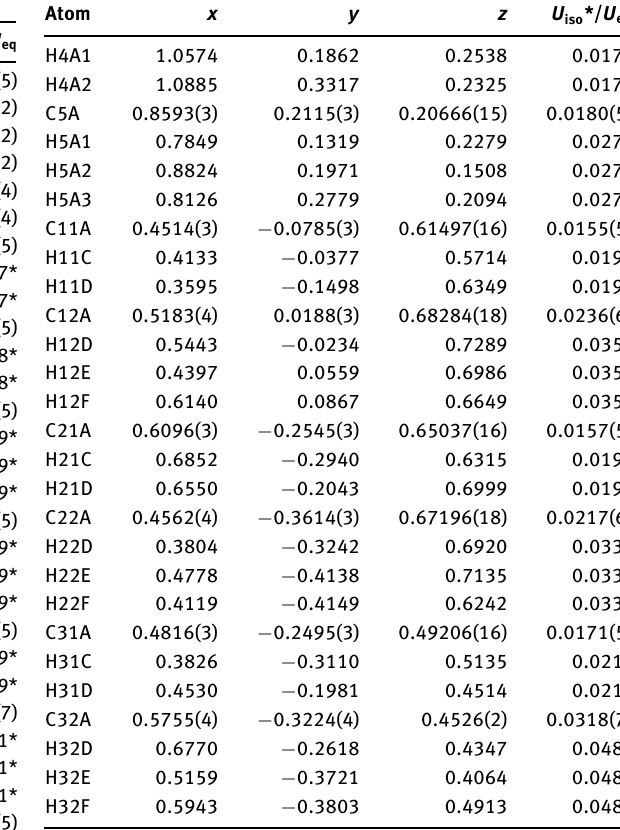
Table 2: Fractional atomic coordinates and isotropic or equivalent isotropic displacement parameters (Å 2